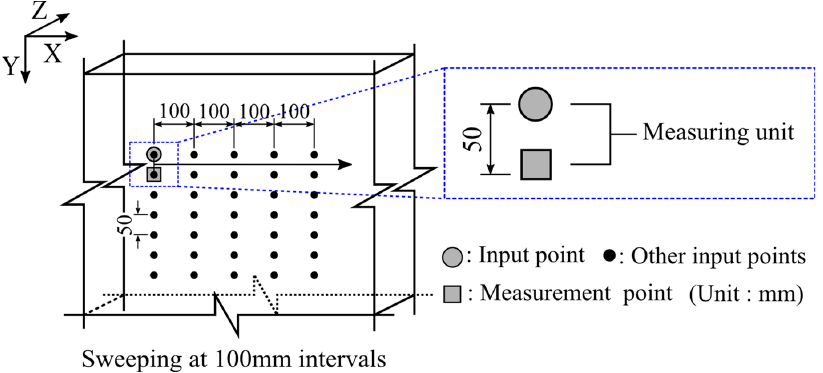
Figure 11. Schematic diagram of the structure and sweep direction of the input and measurement points. Table 3. Location of the input points.